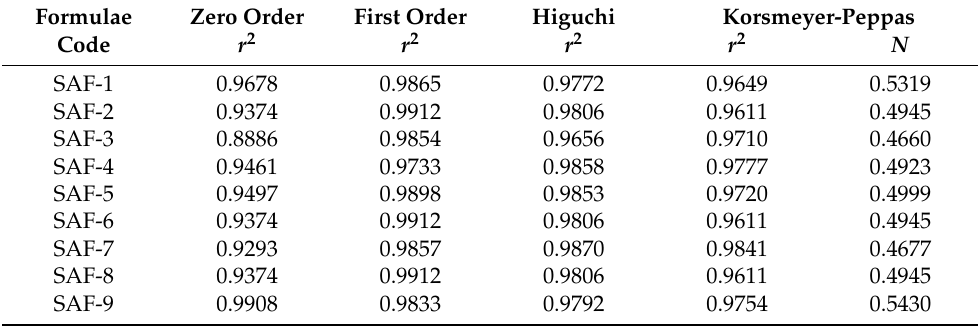
Figure 8. ( A ) Effect of pH on DS release percent from SA-co-poly(AMPS) hydrogels, ( B ) Effect of pH on release percent Figure 8. (A) Effect of pH on DS release percent from SA ‐ co ‐ poly(AMPS) hydrogels, (B) Effect of of commercial product Cataflam, and ( C ) Effect of i—SA, ii—AMPS and iii—MBA contents on DS release percent from SA-co-poly(AMPS) hydrogels at both pH 1.2 and 7.4. pH on release percent of commercial product Cataflam, and (C) Effect of i—SA, ii—AMPS and iii—MBA contents on DS release percent from SA ‐ co ‐ poly(AMPS) hydrogels at both pH 1.2 and Table 3. Kinetic modeling release of DS from SA-co-poly(AMPS) 7.4.